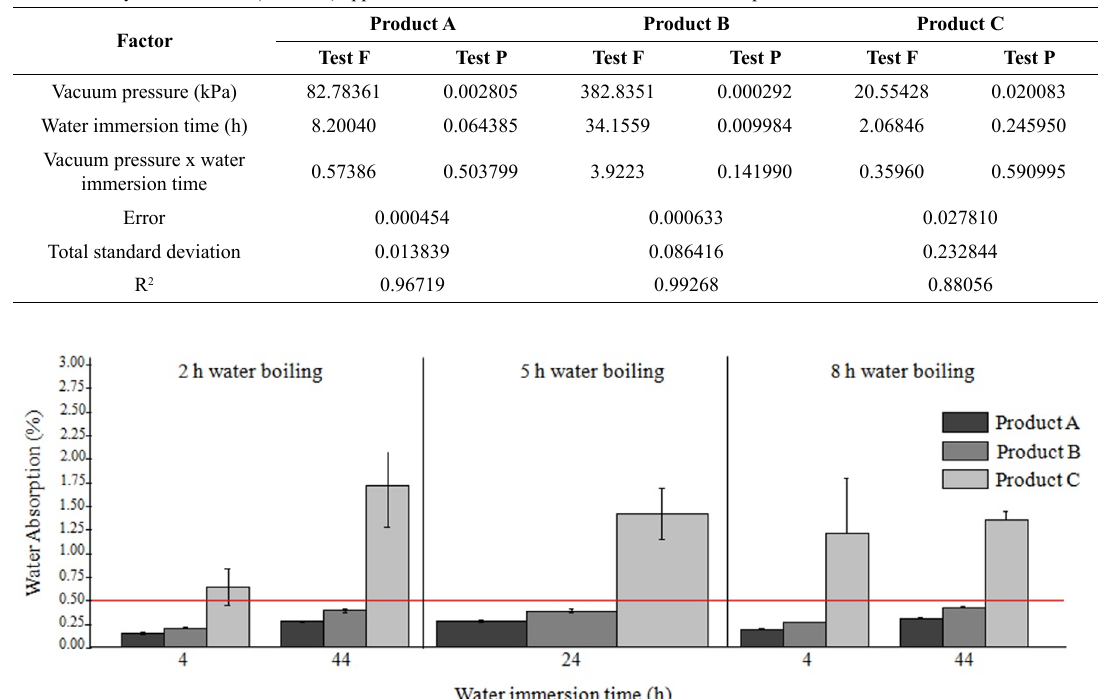
Table 4. Analysis of variance (ANOVA) applied to the WA values in relation to the vacuum pressure and water immersion time.